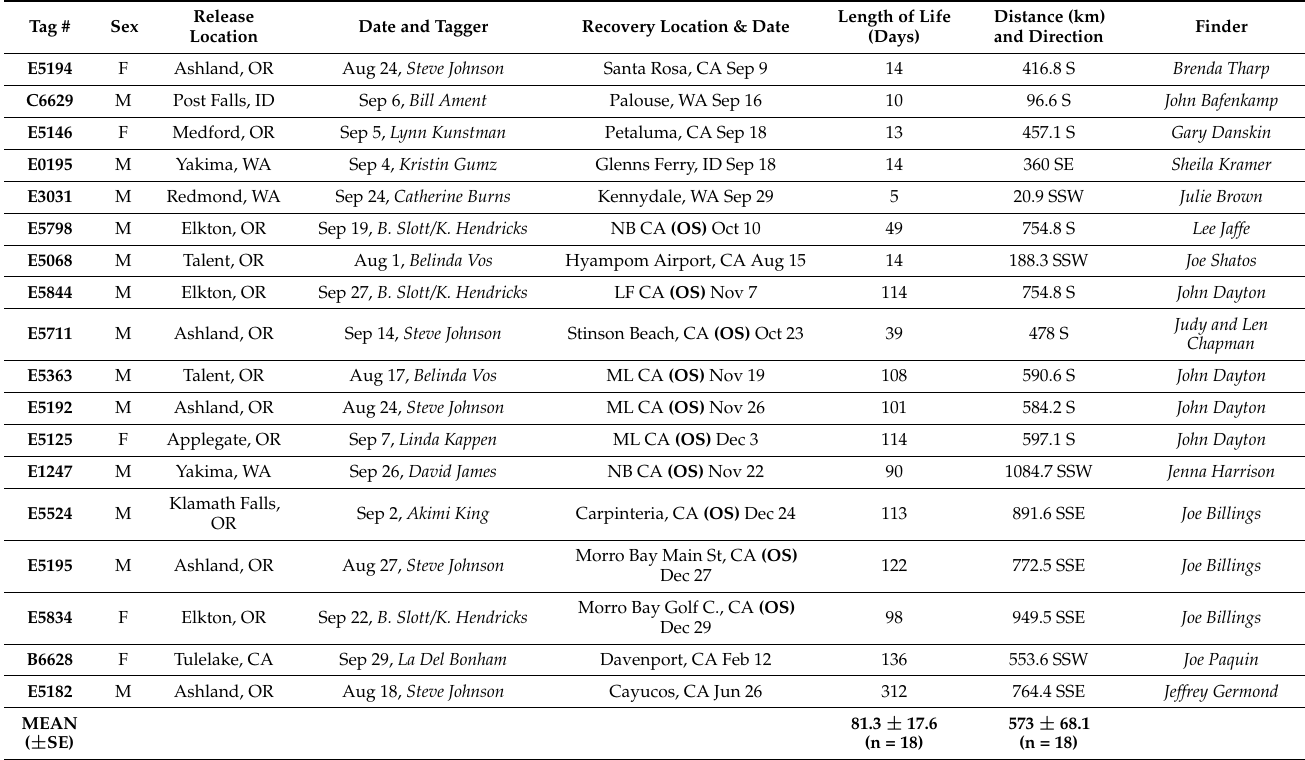
Table 3. Release, recovery, distance, direction and lifespan data for monarchs captive-reared, tagged and released in the PNW during 2018. OS = overwintering site. Santa Cruz overwintering sites: LF = Lighthouse Field State Beach, NB = Natural Bridges State Beach, ML = Moran Lake.